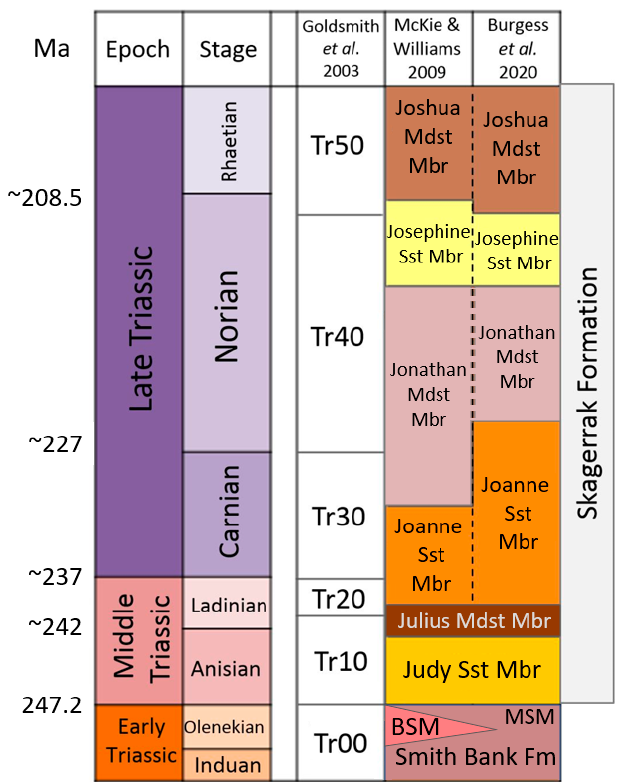
Figure 2. Central North Sea Triassic stratigraphic framework based on Cameron [34], Goldsmith et al. [33], McKie & Williams [21] and Burgess et al. [18]. BSM = Bunter Sandstone Member, MSM = Marnock Shale Member. Timescale from Cohen et al. [36].